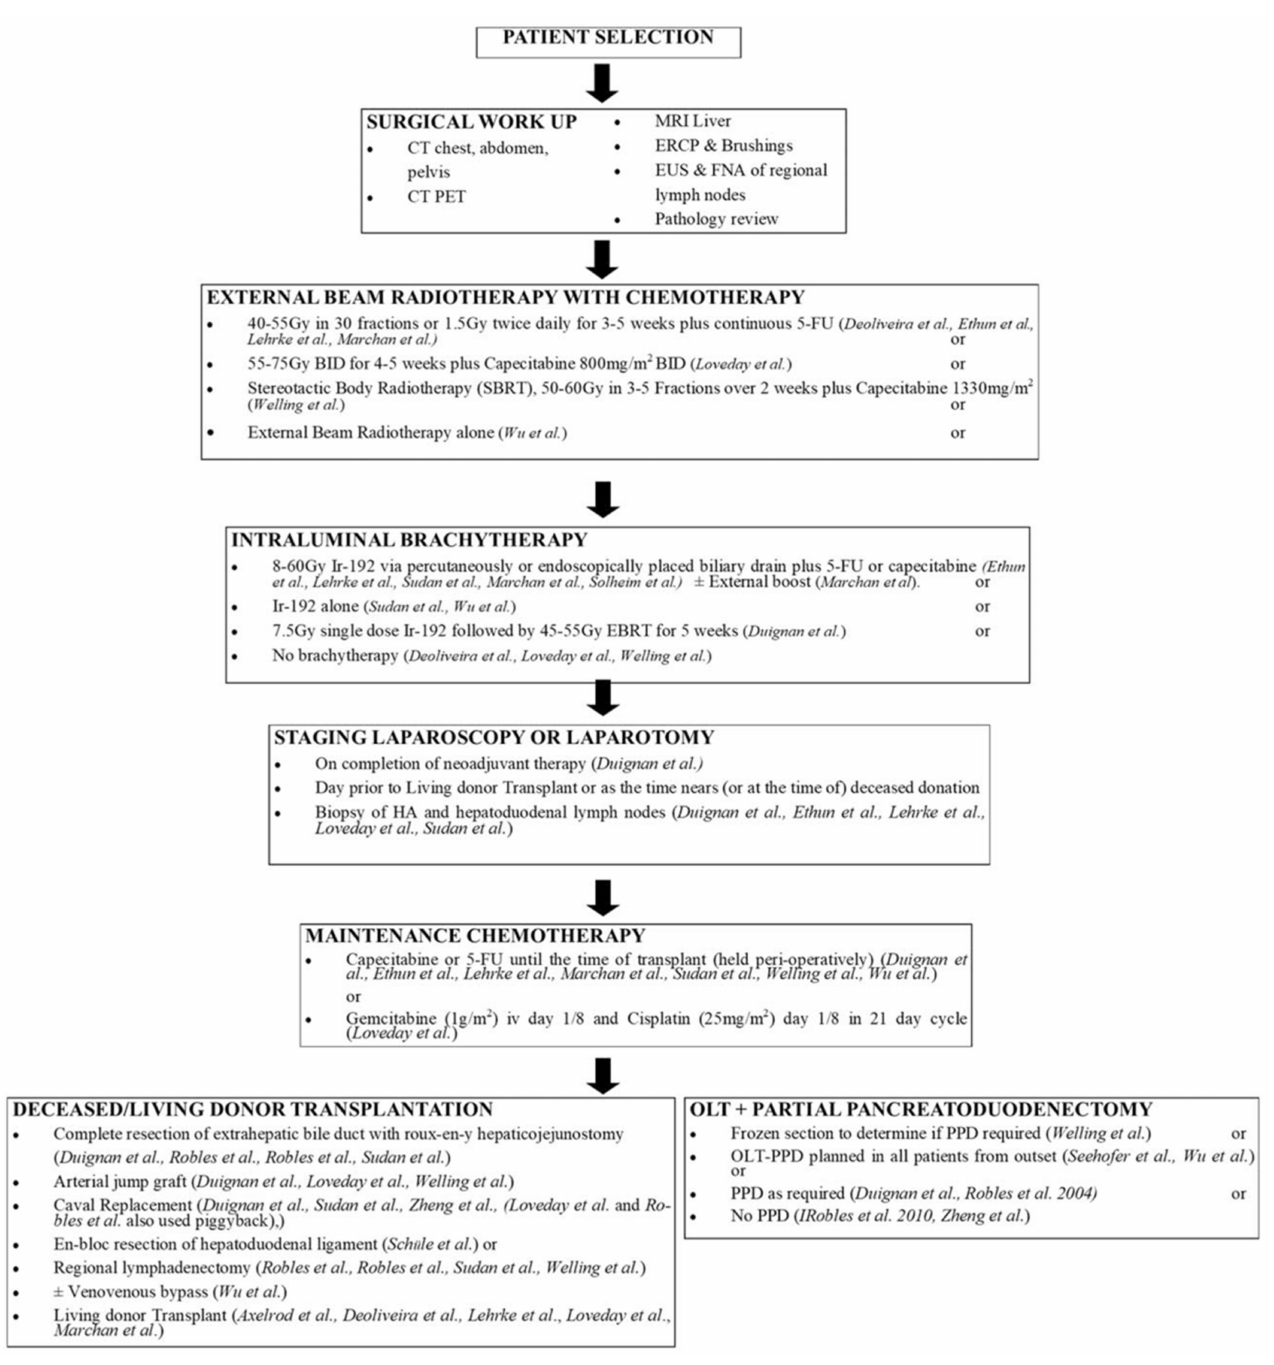
Figure 3. Neoadjuvant protocols leading to liver transplant in perihilar cholangiocarcinoma [106]. Results from a multicenter study that implemented a neoadjuvant chemoradiation protocol prior to transplantation demonstrated an intention-to-treat survival rate at 2 and 5 years of 68% and 53%, respectively, and recurrence-free survival of 78% and 65%, respectively [105]. Several factors were associated with worse outcomes: previous trans- peritoneal biopsy, presence of metastatic disease, or history of other malignancy. Of note, approximately 1 in 10 patients dropped out of the neoadjuvant protocol prior to liver transplant. A recent meta-analysis confirmed the survival benefit of transplantation for well-selected patients with pCCA treated with neoadjuvant chemoradiation therapy and liver transplant [106]. Specifically, patients treated with transplantation compared